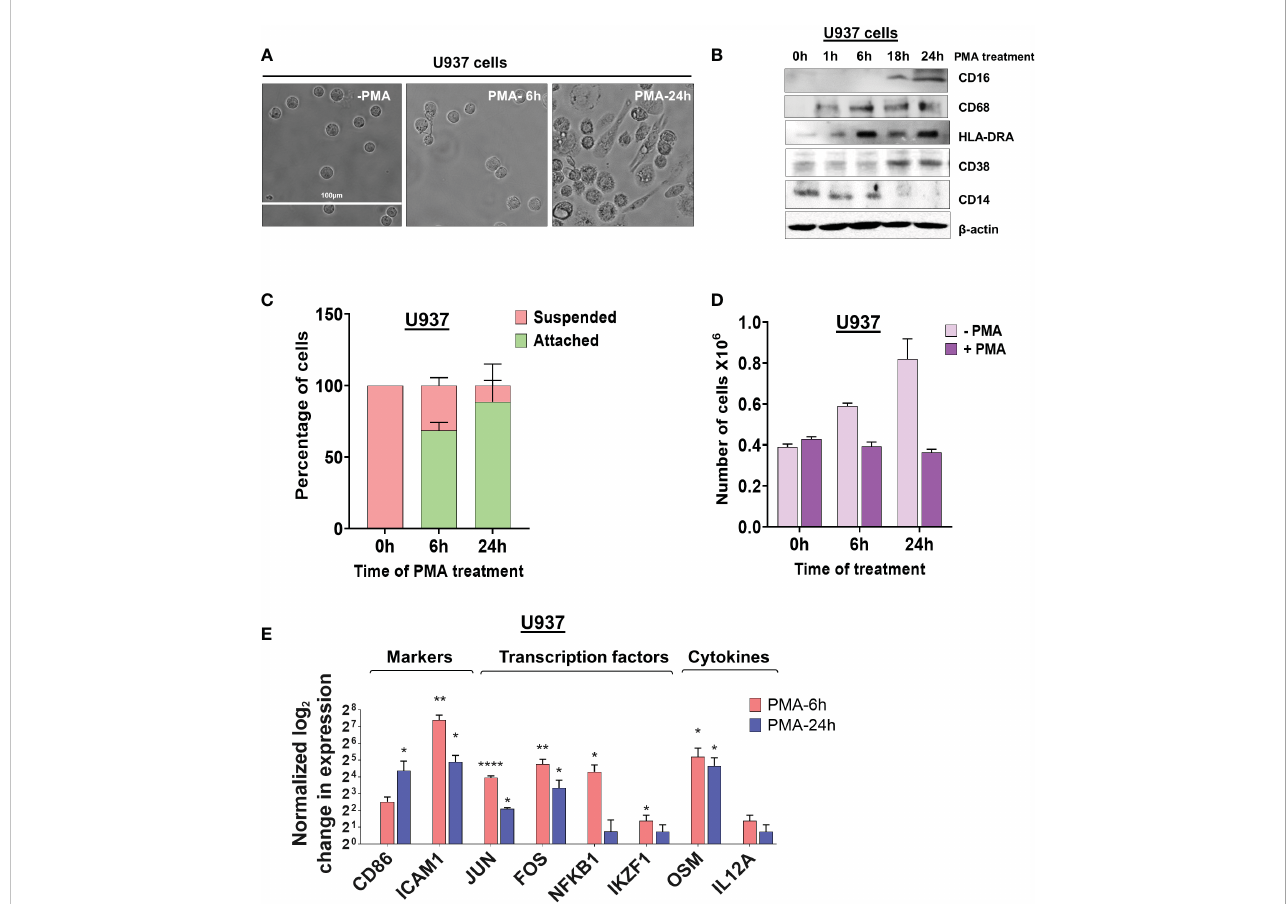
FIGURE 1 Morphological changes and altered expression of cell-surface markers and mRNAs during monocyte differentiation. (A) The effect of differentiation on cellular morphology. U937 cells exposed to PMA (30 nM) for 6 and 24 hours and observed by phase contrast microscopy (40X). (B) Western blots of total cell lysates from U937 cells differentiated with PMA (30 nM) for 0, 1, 6, 18, and 24 hours. Blots were probed with antibodies against CD16, CD68, HLA- DRA, CD38 and CD14 with b -actin as the loading control. (C) Attachment assay of U937 cells. Cells were treated with PMA for 0, 6, and 24 hours and live cells visualized and counted by the Trypan blue exclusion assay. The graph presents the percentage of cells that are suspended or attached. (D) Proliferation assay of U937 cells. The number of cells before and after differentiation depicts the absolute cell number in millions, compared to normal cell proliferation in the absence of PMA. The fi gure represents mean ± SE from three independent experiments. (E) Real-time quantitative PCR (RT- qPCR) – based analysis of the expression of genes important for macrophage differentiation and function (CD86, ICAM1, JUN, FOS, NFKB1, IKZF1, OSM and IL12A) . The RT-qPCR analysis used primers designed in the fi rst exon to represent the total transcript level and the fi gure shows log 2 -fold changes in expression of these genes at 6 hours and 24 hours post PMA treatment of U937 cells, where values are normalized to ACTB mRNA and the 0 hour (no PMA) time point. The fi gure represents mean ± SE from three independent experiments. P value <0.05 was considered signi fi cant, where * = P ≤ 0.05; ** = P ≤ 0.01; **** = P ≤